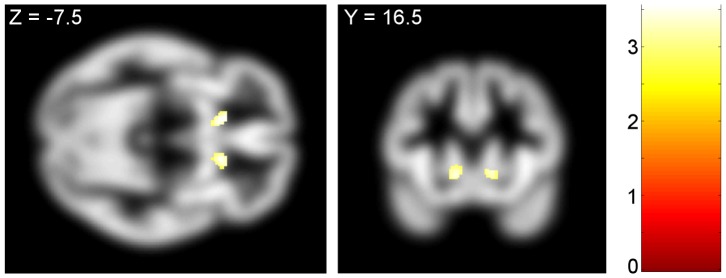
Binge drinkers' ventral striatal grey matter volume is enlarged compared to controls.The SPM image shows greater bilateral ventral striatal grey matter volume in binge drinkers versus controls. Left side: Montreal Neurological Institute peak coordinates (x, y, z; mm): −12.0, 19.5, −6.0; Z = 3.57, FWE-corrected P = 0.030; cluster size  = 52. Right side: (x, y, z): 13.5, 19.5, −6.0; Z = 3.28, FWE-corrected P = 0.030; cluster size  = 49. The image is shown at whole brain uncorrected P<0.005, cluster size >0, overlaid on the mean group grey matter image, and masked according to the region of interest. Voxel-wise t-values are color coded according to legend. The images are displayed in neurological convention.